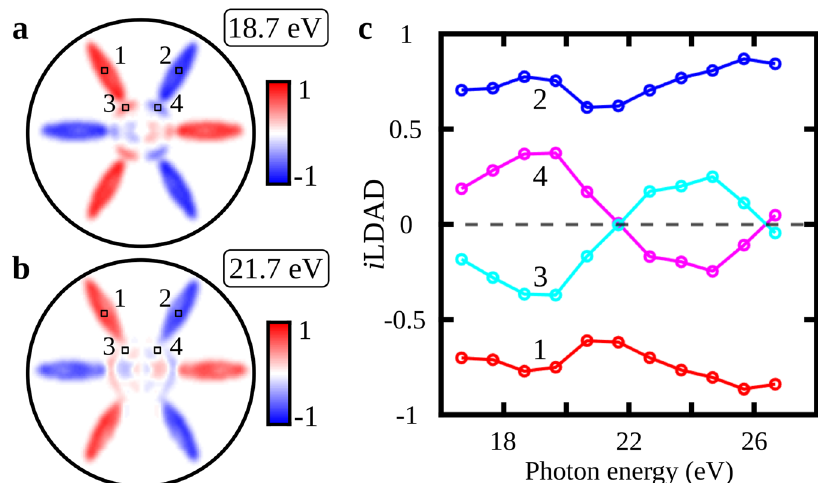
Fig. 4 Photon energy dependence of i LDAD calculated using the KKR method. a and b i LDAD calculated using the KKR and a photon energy of 18.7 eV. The regions of interest label 1 – 4 are selected to investigate the photon energy dependence of i LDAD. b i LDAD as a function of photon energy, in the selected region of interest shown in ( a ).